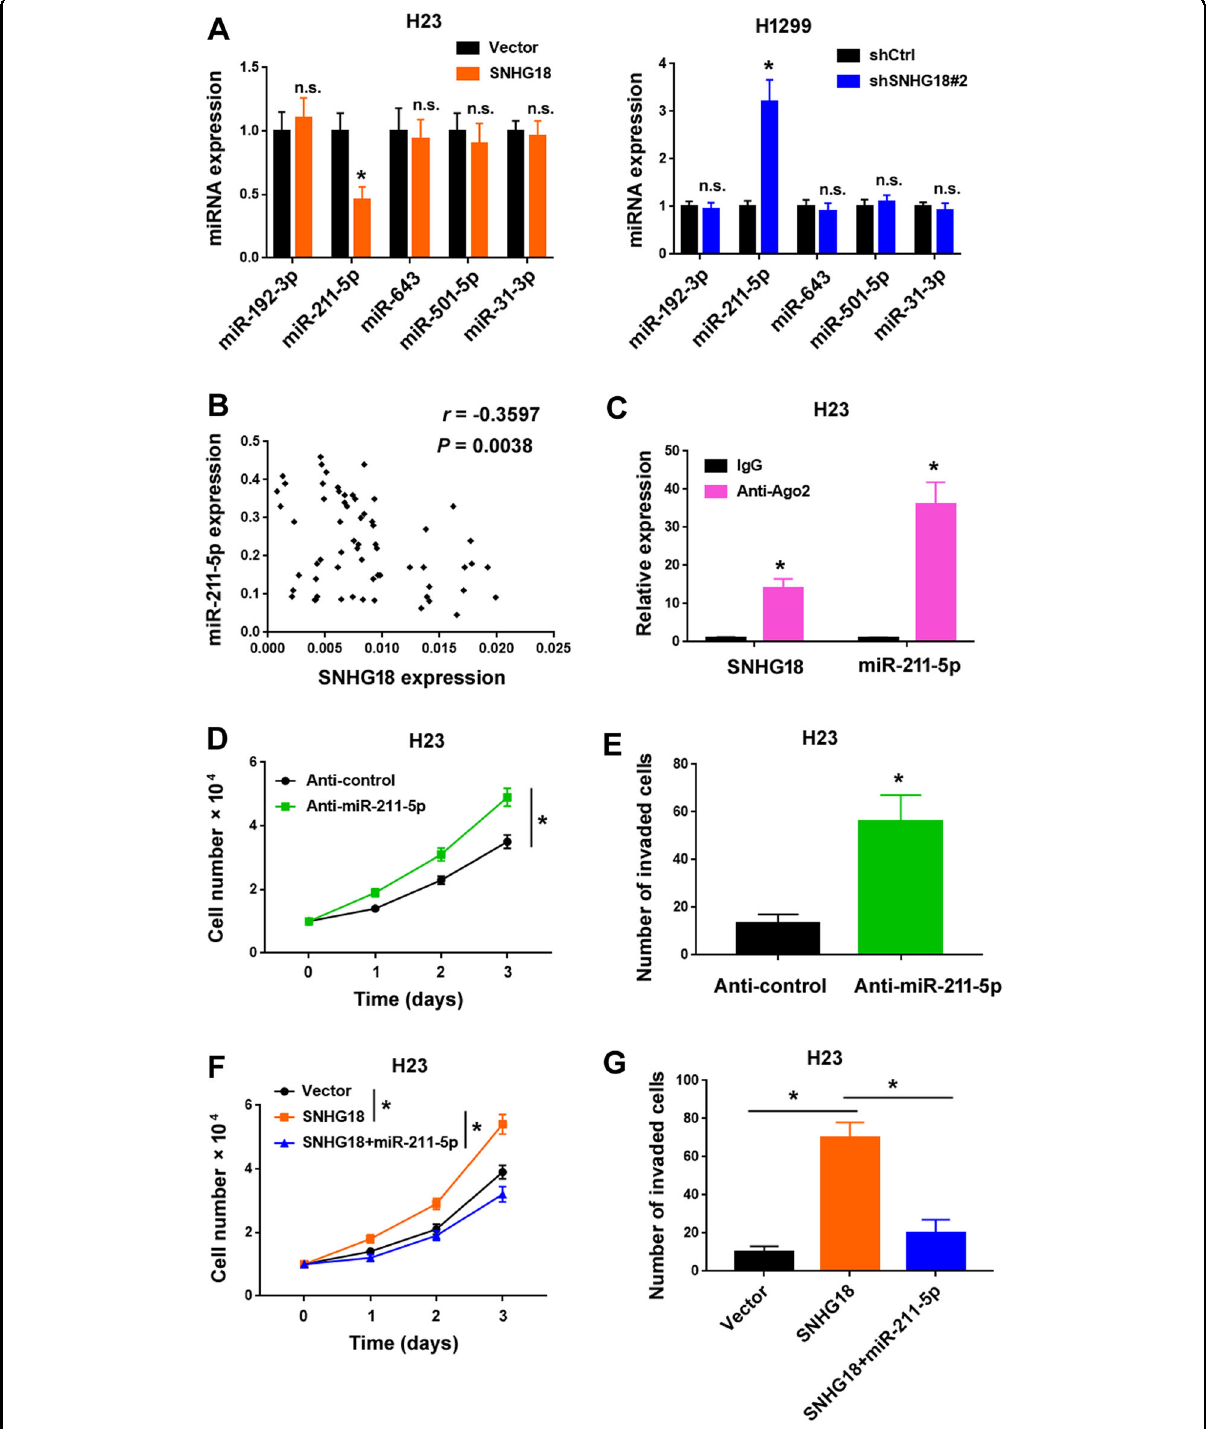
Fig. 6 SNHG18 interacts with miR-211-5p and antagonizes its inhibitory effects against NSCLC. A Quantitative PCR analysis of indicated miRNAs in H23 and H1299 cells transfected with indicated constructs. n.s. indicates no signi fi cance. * P < 0.05 vs. vector or shCtrl. n = 3. B A n alysis of the correlation between SNHG18 and miR-211-5p expression in 63 NSCLC cases. C Ago2 RIP assay showed that SNHG18 and miR-211-5p were enriched in Ago2 immunoprecipitates from H1299 cells. n = 3. D , F Assessment of the proliferation of H23 cells transfected with indicated constructs. * P < 0.05 by one-way ANOVA and Bonferroni ’ s test in ( F ). n = 4. E , G Measurement of the invasion of H23 cells transfected with indicated constructs. * P < 0.05 by one-way ANOVA and Bonferroni ’ s test in ( G ). n = 3. In all panels in this fi gure, Student ’ s t -tests were performed unless otherwise